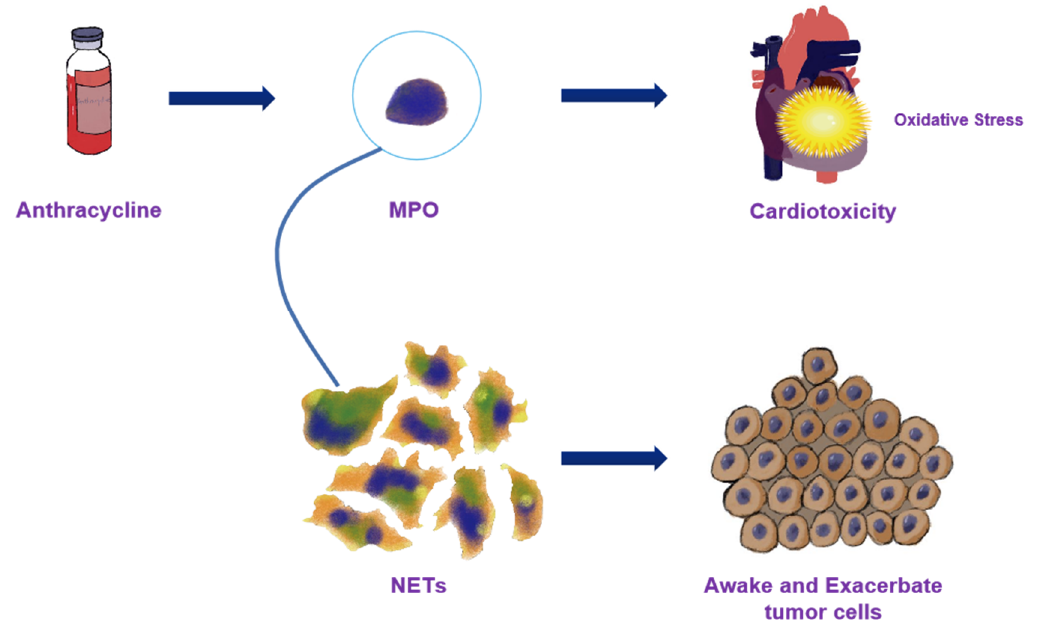
Figure 6. The potential mechanism of MPO increasing after cancer therapy. MPO: myeloperoxidase; NETs: neutrophil extracellular traps.